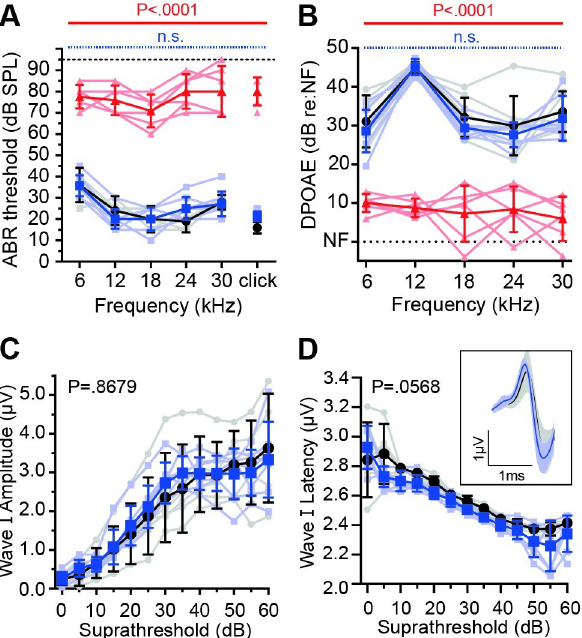
Fig 11. Neuroplastin genetically interacts with Cadherin 23 . Phenotypic measures of Nptn tm1b mice maintained on a Cdh23 -repaired C57BL/6N ( Cdh23 753A > G ) background. (A) ABR threshold measurements recorded from 4-week old mice. Similar to Nptn tm1b/tm1b mice on the standard C57BL/6N genetic background, Nptn tm1b/tm1b mice on the repaired background (red triangles, n = 6) have profoundly elevated thresholds compared with littermate Nptn +/+ mice (black circles, n = 5). However, on the repaired background Nptn +/tm1b (blue squares, n = 7) have thresholds indistinguishable from control mice, even at the higher frequencies. Data are median ± IQR with individual data points shown. One-way ANOVA comparing against wild type controls using Dunnett’s test for multiple comparisons. (B) DPOAE measurements recorded at 5-6-weeks of age. Response amplitudes were significantly reduced in Nptn tm1b/tm1b mice (red triangles, n = 5), whereas Nptn +/tm1b mice (blue squares, n = 5) have amplitudes comparable to that of control mice ( Nptn +/+ , black circles, n = 5). Data are mean ± SD with individual data points shown. One-way ANOVA comparing against wild type controls using Dunnett’s test for multiple comparisons. (C, D) Click-evoked ABR wave I comparing Nptn +/+ (black, n = 5) and Nptn +/tm1b (blue, n = 7) mice. Waveforms were not significantly different. Amplitude: P = 0.8679, Latency: P = 0.0568 (two-way ANOVA). Inset shows an average of wave I following a click stimulus at 30 dB above threshold. Data are mean ± SD with individual data points